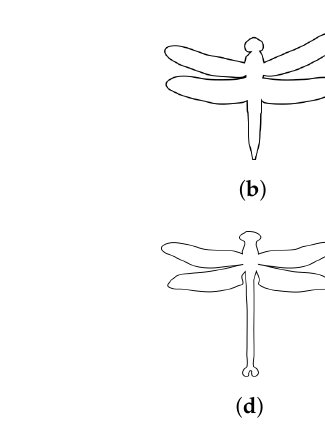
Figure 1. Outlines of representative dragonflies from different families. ( a ) Aeshnidae, Epiaeschna heros . ( b ) Libellulidae, Libellula croceipennis Selys. ( c ) Gomphidae, Erpetogomphus designatus Hagen. ( d ) Petaluridae, Petalura ingentissima ; Reprint with permission [27], c (cid:13) 2000, Entomological Society of America.